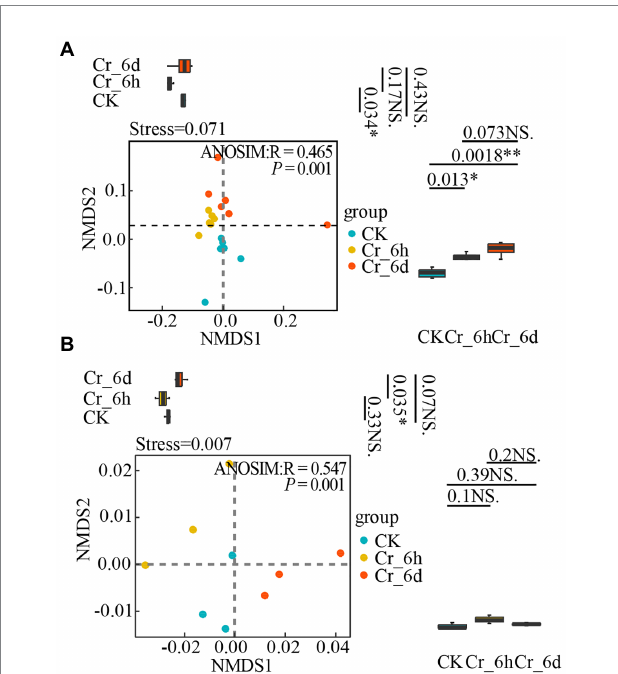
FIGURE 5 Non-metric multidimensional scale analysis of bacterial communities (A) and nitrogen cycle functional genes (B) in chromium-contaminated soils. Significance (P), * p ≤ 0.05, ** p ≤ 0.01, *** p ≤ 0.001, NS, no significant difference; CK, control treatment; Cr_6h, Cr stress for 6 h; Cr_6d, Cr stress for 6 days. The R value indicates whether there is a difference between different groups, and R > 0 indicates that the difference between groups is greater than the difference within groups. Points of different colors or shapes represent samples of different treatments. The closer the two sample points, the more similar the species composition of the two samples. The upper, middle, and lower lines of the box chart represent the upper quartile, median, and lower quartile, respectively, and the vertical line is the error bar.